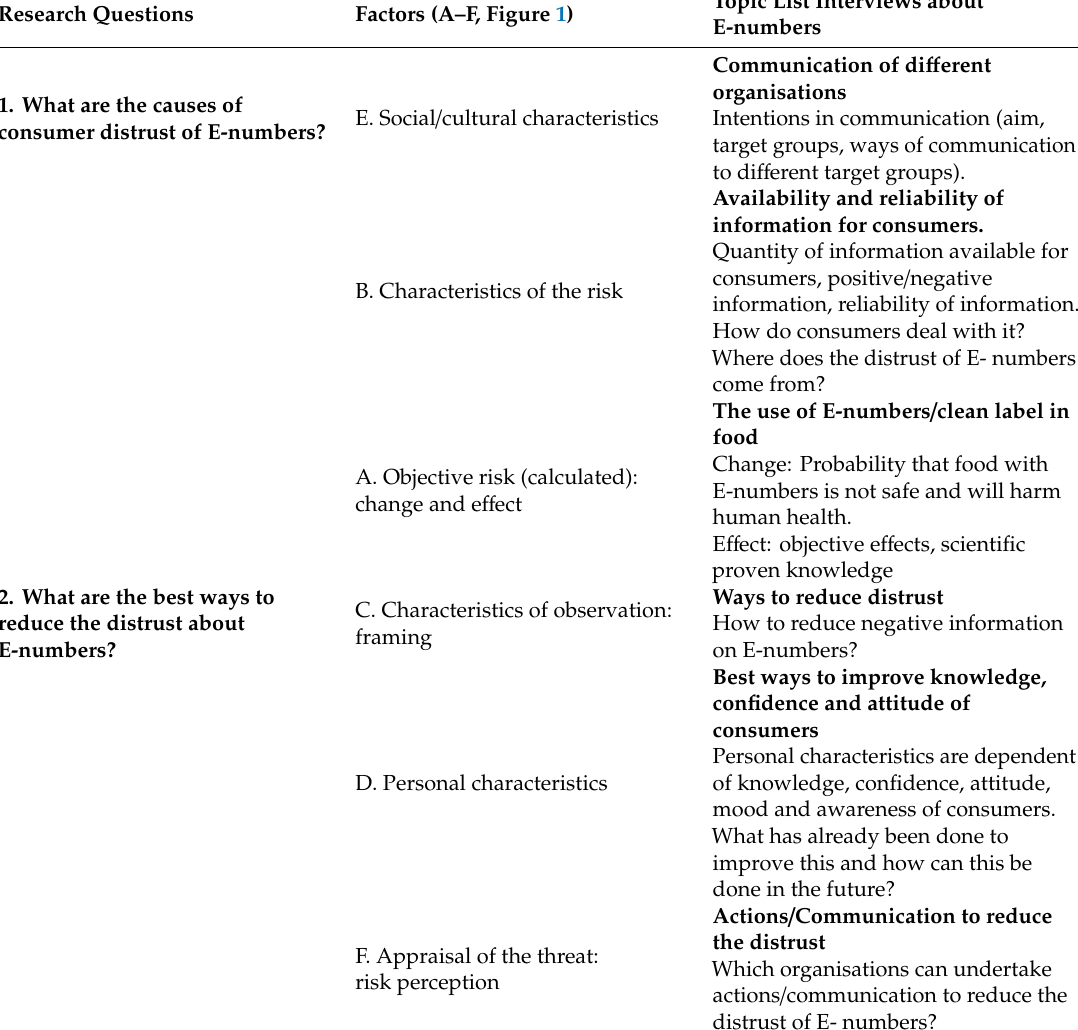
Table 1. Topic list interviews based upon 2 research questions and risk factors of Figure 1 (A t / m F).